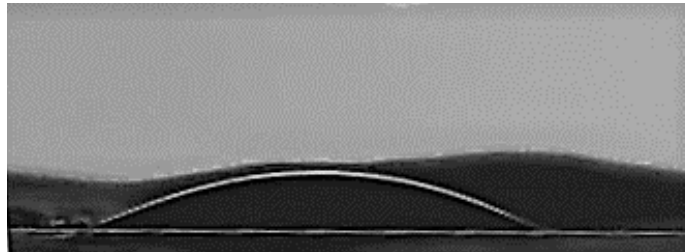
Figure 9. Water contact angle on inulin – TEOS hybrid adsorbent.